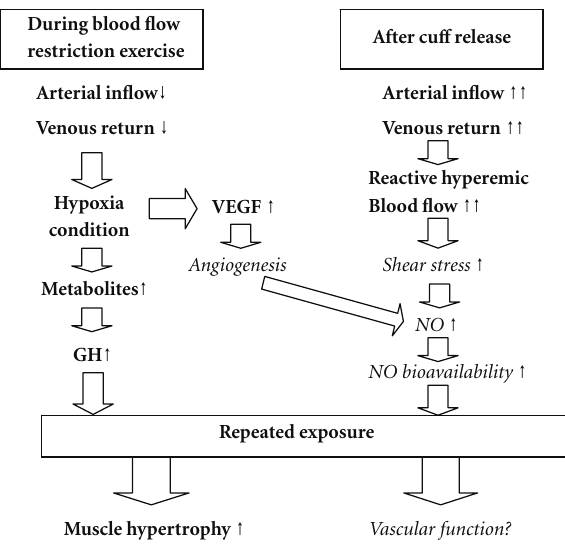
Figure 1: Hypothesised changes in vascular function in response to BFR exercise and training. BFR, blood flow restriction; GH, growth hormone; NO, nitric oxide; VEGF, vascular endothelial growth factor; Bold refers to known results from previous studies and Italic means unknown and inconsistent results form previous